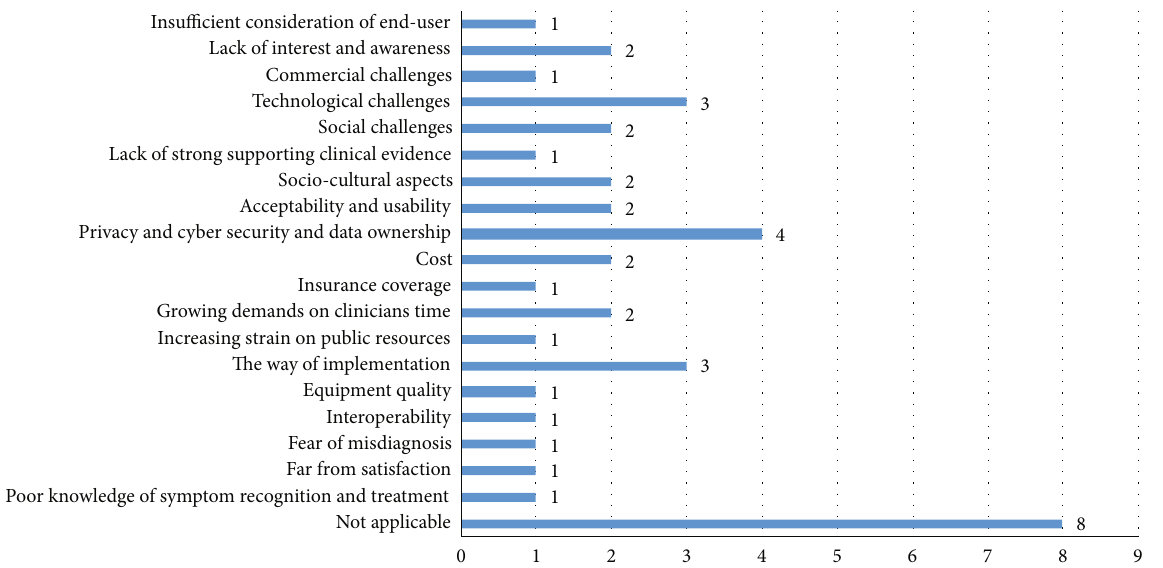
Figure 3: Frequency of addressed challenges of applying personalized mobile apps for elderly